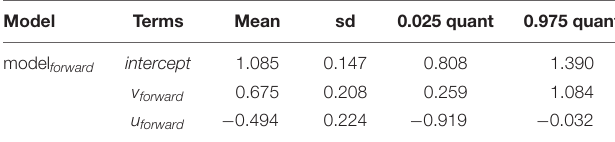
TABLE 2 | Posterior mean values, standard deviation (sd) and 95% credible intervals (0.025 quant, 0.975 quant) of the final full model (model forward ) indicating all terms being